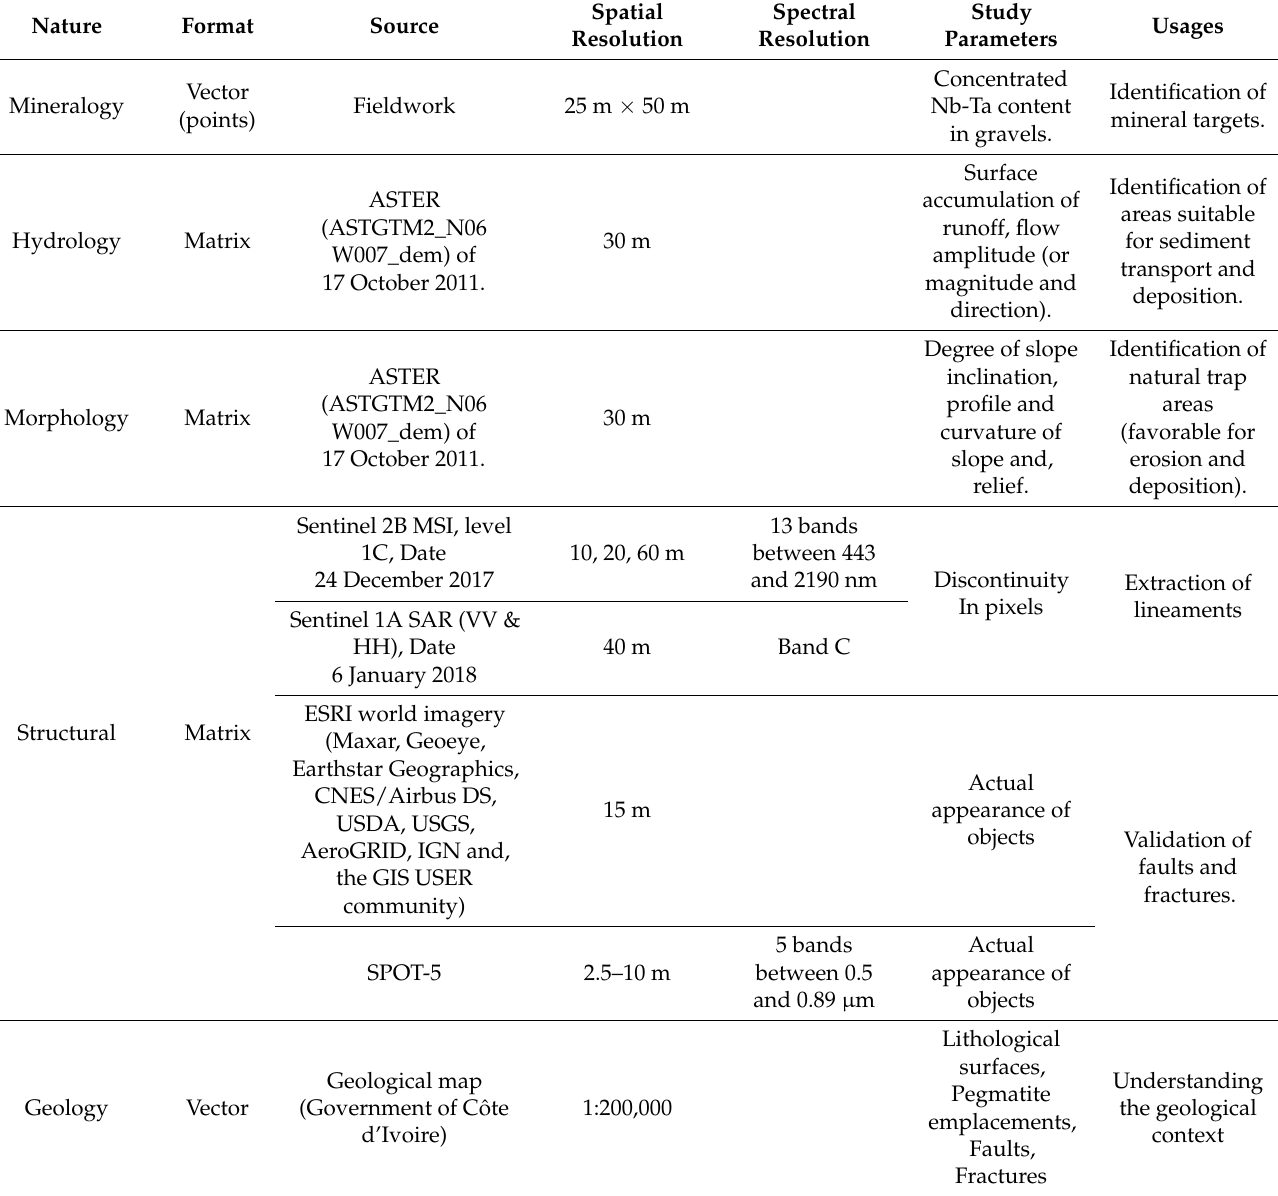
Table 1. Summary of data that were used in this